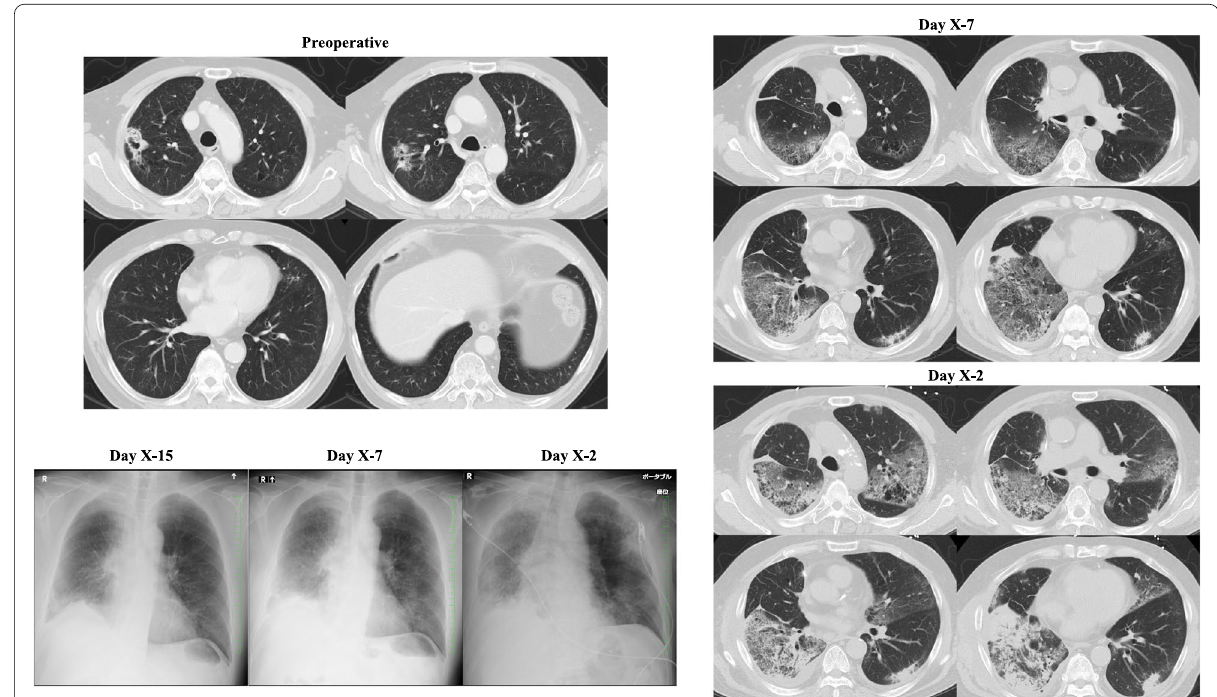
Fig. 1 X-ray and computed tomography images of the patient’s chest before and after lung cancer resection. Preoperative examination revealed a lung cancer lesion in the right upper lobe. Examination upon postoperative readmission showed diffuse frosted shadows predominantly in the right lung (day X-7). However, upon intensive care unit (ICU) admission (day X-2), there were enlarged diffuse frosted shadows in both lung